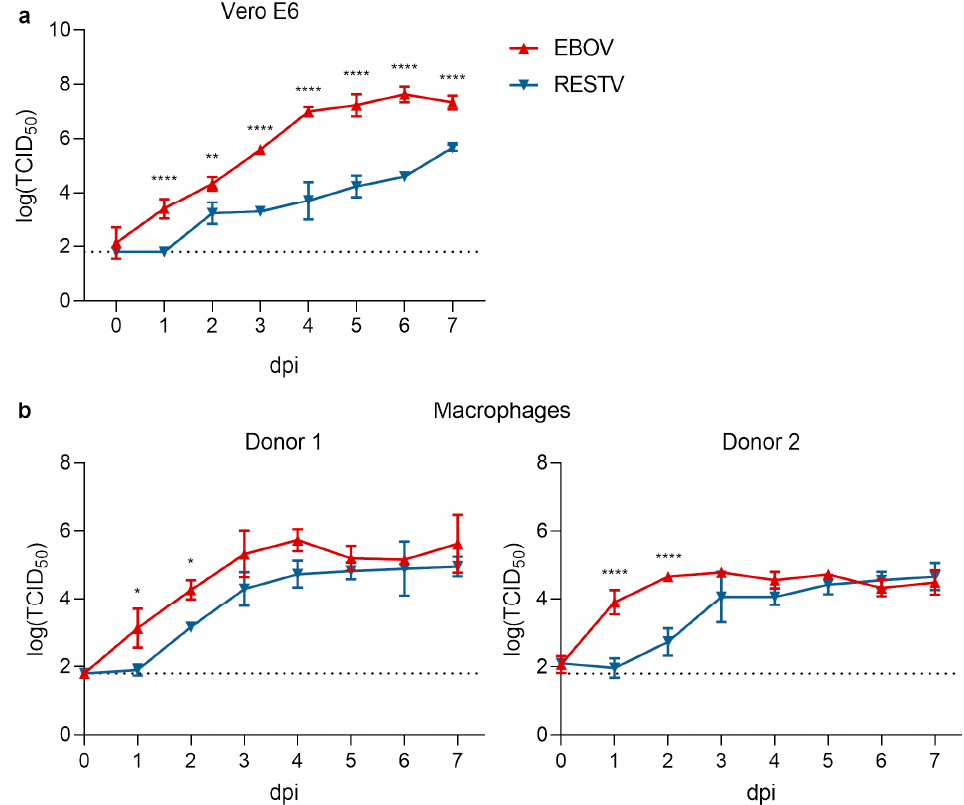
Figure 1. Comparison of in vitro growth kinetics of Ebola virus (EBOV) and Reston virus (RESTV). ( a ) Growth kinetics in Vero E6 cells infected with 1 × 10 4 50% tissue culture infectious dose (TCID 50 ) (multiplicity of infection, MOI = 0.01) of EBOV (red) or RESTV (blue). ( b ) Growth kinetics in primary monocyte-derived human macrophages infected with 1 × 10 4 TCID 50 (MOI = 0.01) of EBOV (red) and RESTV (blue). Viral titers (TCID 50 ) in the supernatant at the indicated days post-infection (dpi) are shown. The dotted line indicates the limit of detection of the TCID 50 assay. In all panels, means and standard deviations of 3 biological replicates are shown. *: p < 0.5; **: p < 0.01; ****: p <